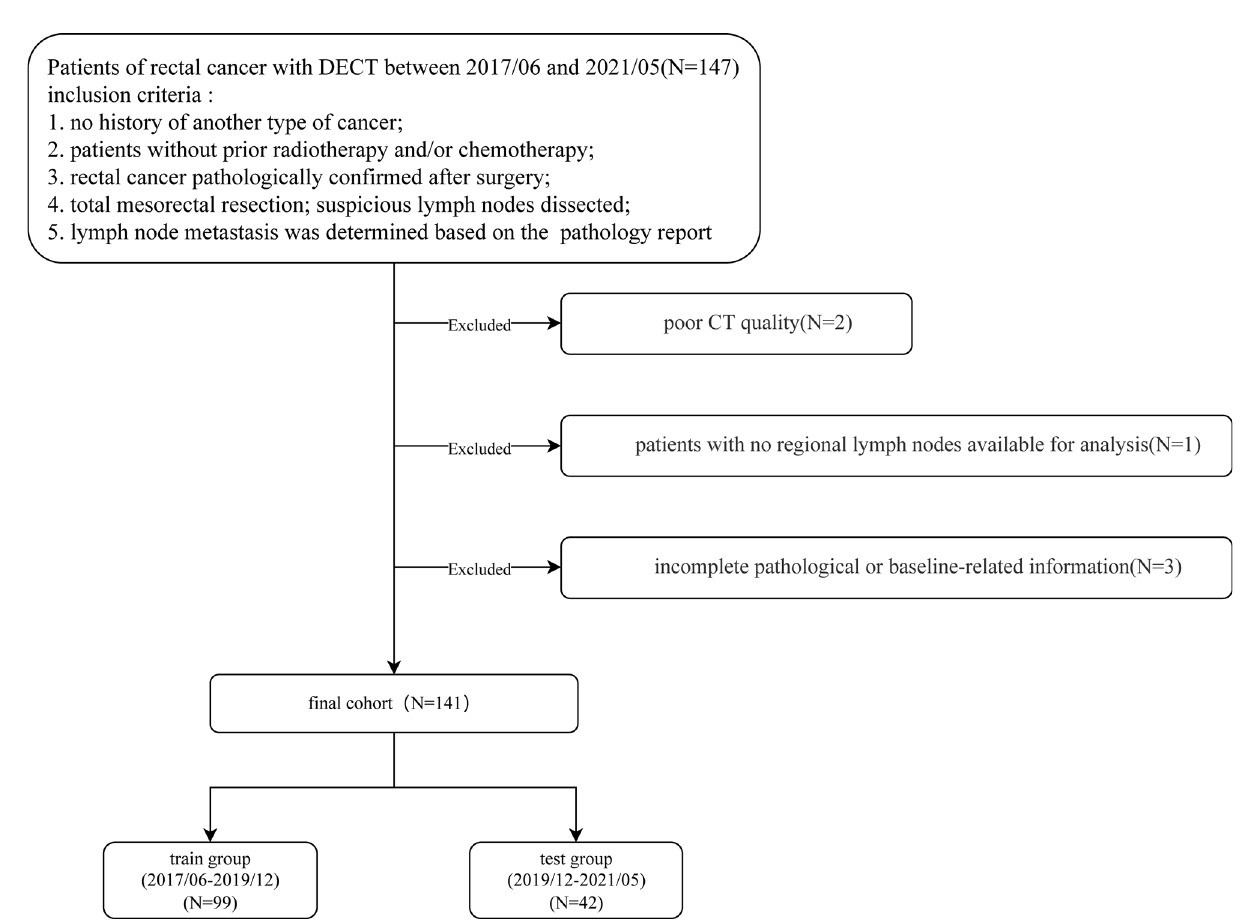
FIGURE 1 | Patient selection fl